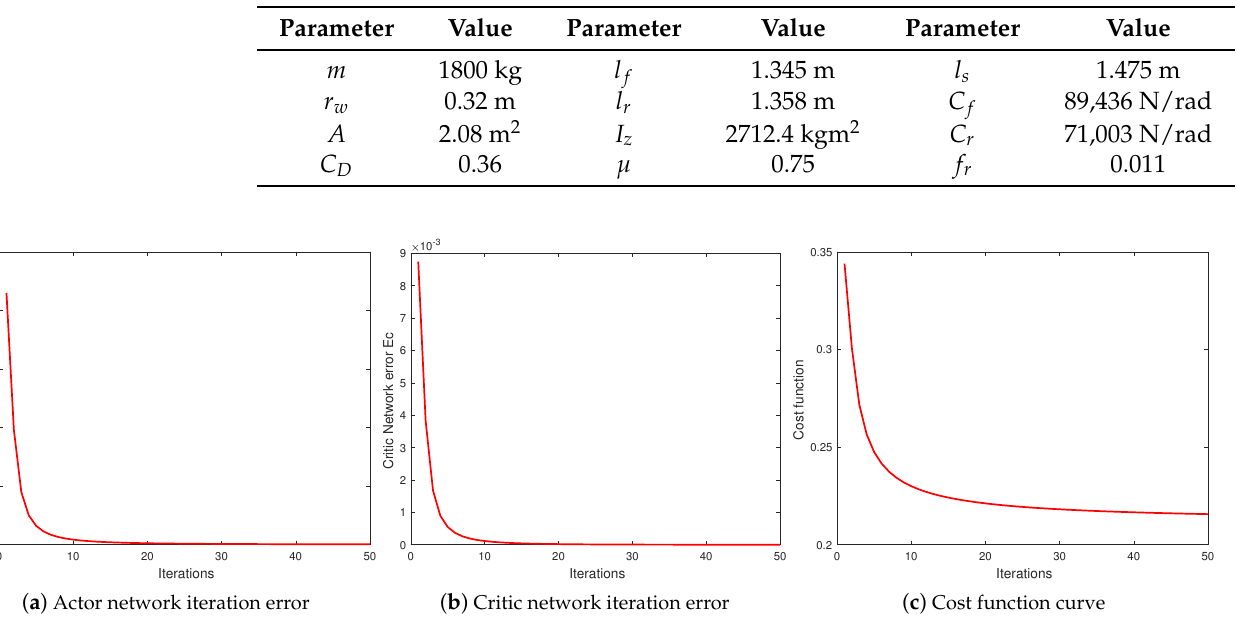
( c ) Cost function curve